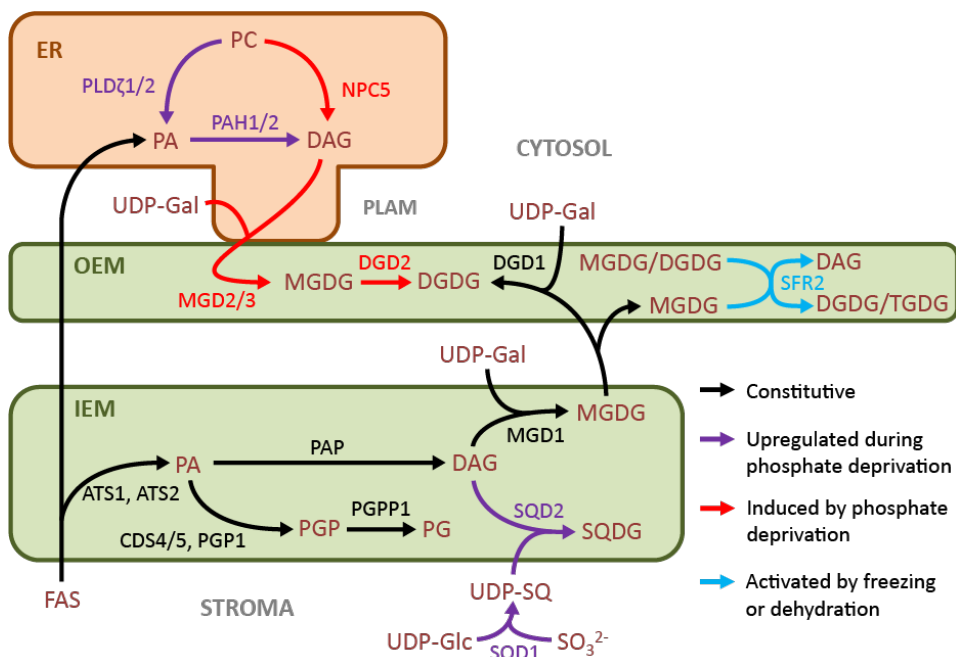
Figure 2. Chloroplast lipid metabolism as a scaffold for metabolic responses to environmental stress. In black, constitutive lipid metabolism in unstressed plants; in purple, constitutive pathways that are upregulated in response to phosphate deprivation; in red, non-constitutive pathways that are turned on during phosphate deprivation; in blue, pathways activated by freezing or dehydration stress. List of abbreviations in alphabetical order: ATS1/2, GLYCEROL-3-PHOSPHATE ACYLTRANSFERASE 1/2; CDS4/5, CYTIDINE DIPHOSPHATE DIACYLGLYCEROL SYNTHASE 4/5; DAG, diacylglycerol; DGD1, UDP-GALACTOSE:MGDG GALACTOSYLTRANSFERASE; DGD2, DIGALACTOSYLDIACYLGLYCEROL SYNTHASE 2; DGDG, digalactosyldiacylglycerol; ER, en- doplasmic reticulum; MGDs, monogalactosyldiacylglycerol synthases; MGDG, monogalactosyl- diacylglycerol; NPC5, NON-SPECIFIC PHOSPHOLIPASE C5; PA, phosphatidic acid; PAH1 and PAH2, PHOSPHATIDIC ACID PHOSPHOHYDROLASE1 and 2; PAP, PHOSPHATIDIC ACID PHOS- PHATASE; PC, phosphatidylcholine; PG, phosphatidylglycerol; PGP, phosphatidylglycerol phos- phate; PGPP1, PHOSPHATIDYLGLYCEROPHOSPHATE PHOSPHATASE1; PLAM, plastid